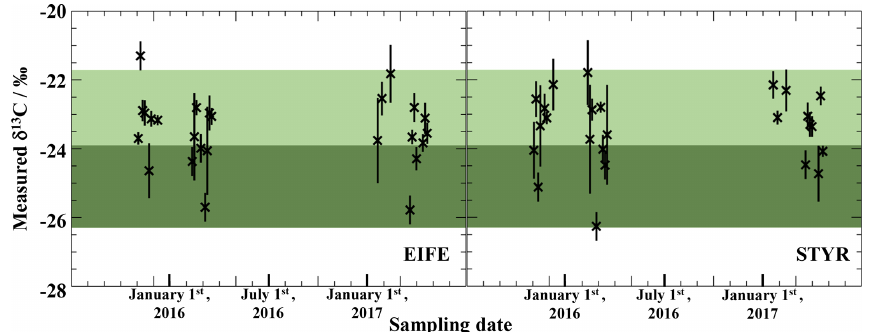
Figure 5. δ 13 C of the sampled levoglucosan at EIFE and STYR sites. The shaded areas represent ranges of observed levoglucosan source specific isotope ratios in aerosol formed during the combustion of soft (light green) and hard wood (dark green) (Sang et al., 2012).